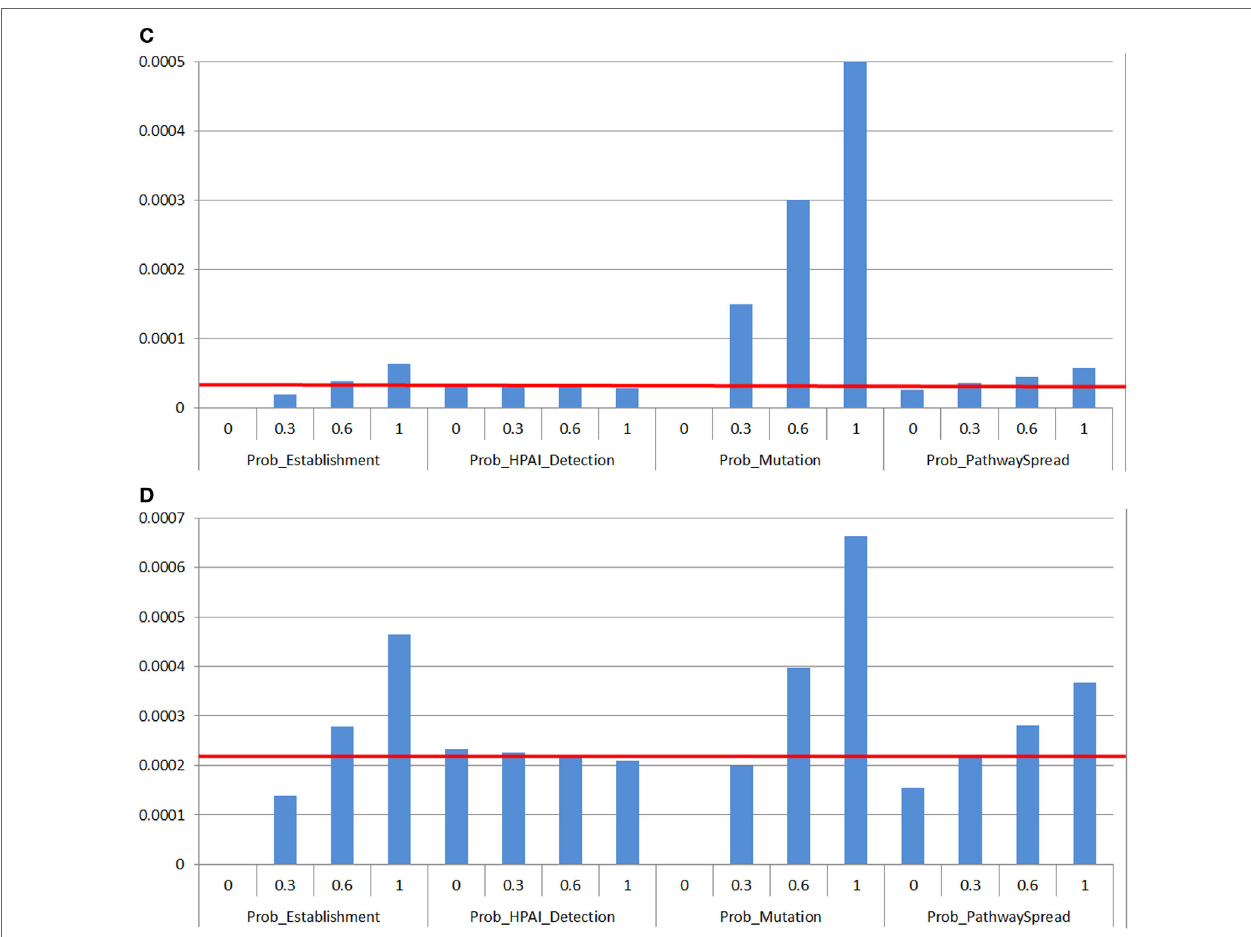
FigUre 5 | Results of the sensitivity analysis on the spread assessment depicting the change in probability (Y-axis) on the median overall probability of low- pathogenic avian influenza (LPAI) or high-pathogenic avian influenza (HPAI) spread (horizontal line) between sheds on a commercial poultry farm and between commercial poultry farms after exposure of one chicken to low-pathogenic avian influenza (LPAI) virus from wild birds in Australia with changes of certain input variables listed in Table 1 ( X -axis). Results were obtained from a simulation of 1,000 iterations using @Risk’s Advanced Sensitivity Analysis. The outcomes were similar in proportional increase in value among all farm types so only one example of a meat chicken or layer farm type per LPAI (a,B) or HPAI (c,D) spread between sheds and farms was used. (a) Sensitivity analysis on input parameters affecting the probability of LPAI spread between sheds and farms on free range meat chicken farm types. (B) Sensitivity analysis on input parameters affecting the probability of LPAI spread between sheds and farms on free range layer farm types. (c) Sensitivity analysis on input parameters affecting the probability of HPAI spread between sheds and farms on barn meat chicken farm types. (D) Sensitivity analysis on input parameters affecting the probability of HPAI spread between sheds and farms on cage layer farm types. Prob_Establishment , Probability that the H5/H7 LPAI subtype will establish within the flock from one infected chicken; Prob_Mutation , Probability that LPAI established within the flock will mutate to HPAI; Prob_LPAI_Detection , Probability that the farmer will detect and report disease to appropriate officials during LPAI establishment; Prob_HPAI_Detection , Probability that HPAI will produce clinical signs with the assumption that the probability of detection is extremely high; Prob_PathwaySpread , Probability of any one of the spread pathways identified, with consideration of the complementary changes for all other spread pathways that will result given sum of the probabilities of all pathways occurring equaled